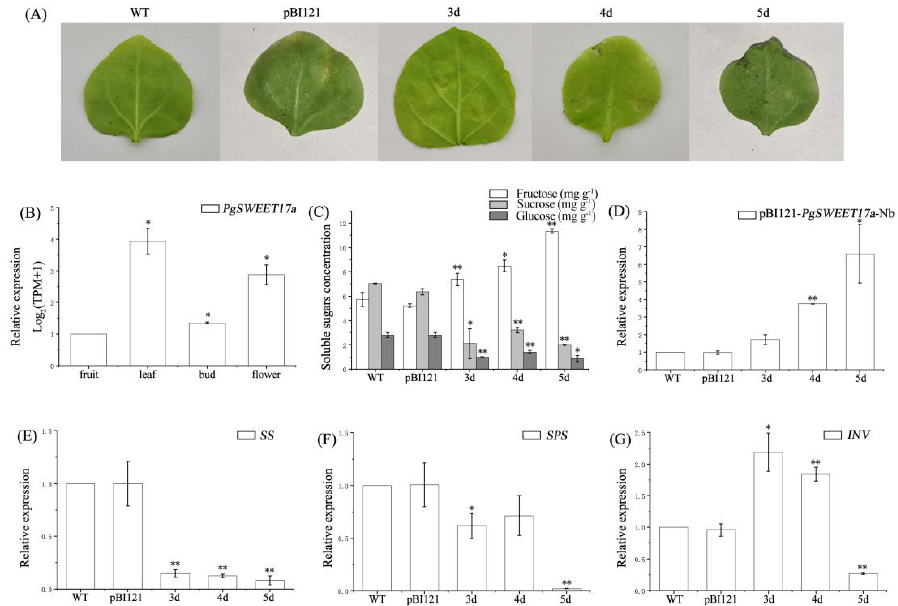
Figure 9. Tobacco transient expression results. Images of wild-type (WT), pBI121- overexpression and PgSWEET17a -overexpression tobacco leaves ( A ). PgSWEET17a expression of different organs